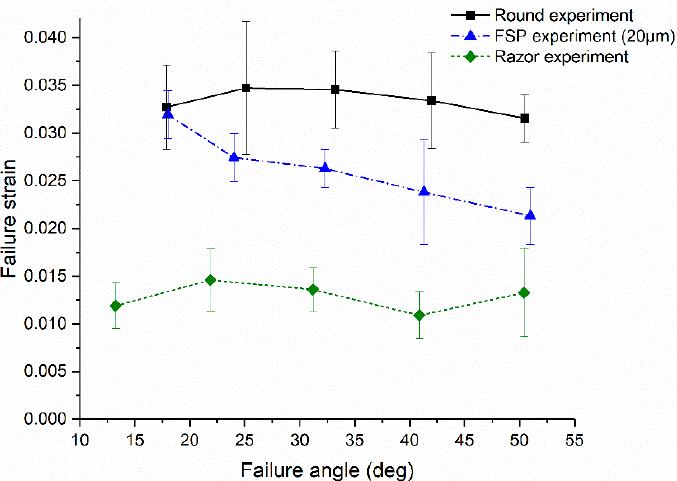
Figure 11. Effect of breaking angle on the axial failure strain for the SK-76 single fiber. Reproduced from [15], Sage Publishing, 2019.